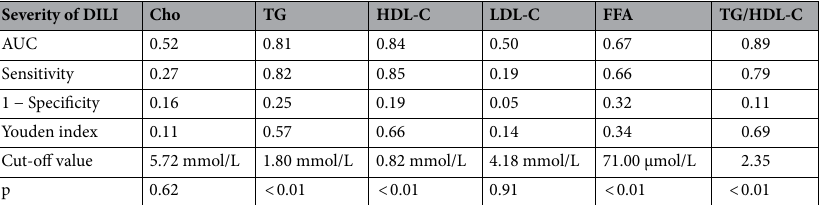
Table 5. Receiver operating characteristic (ROC) curve analysis of serum lipid levels and TG/HDL-C ratio for diagnosis of severe DILI. TG triglyceride, Cho cholesterol, LDL-C low-density lipoprotein cholesterol,